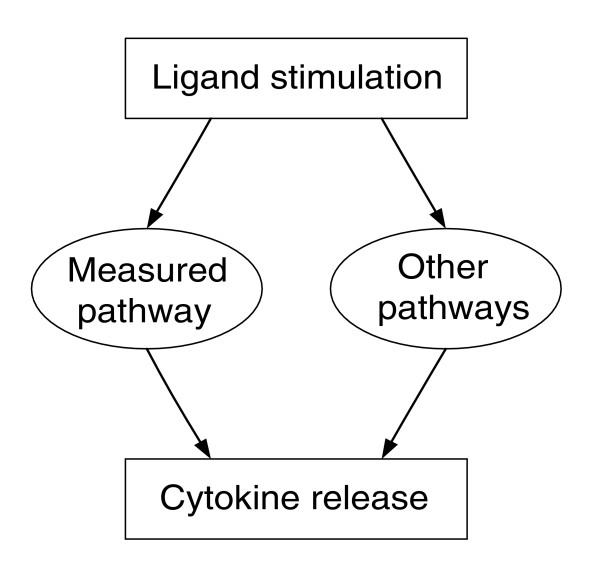
Schematic representation of the experimental data. RAW 264.7 macrophages were stimulated with different combinations of ligands. Signals leading to cytokine release were transmitted not only through the 22 signaling proteins and a second messenger that were recorded (measured pathways), but also through other pathways (unmeasured pathways).